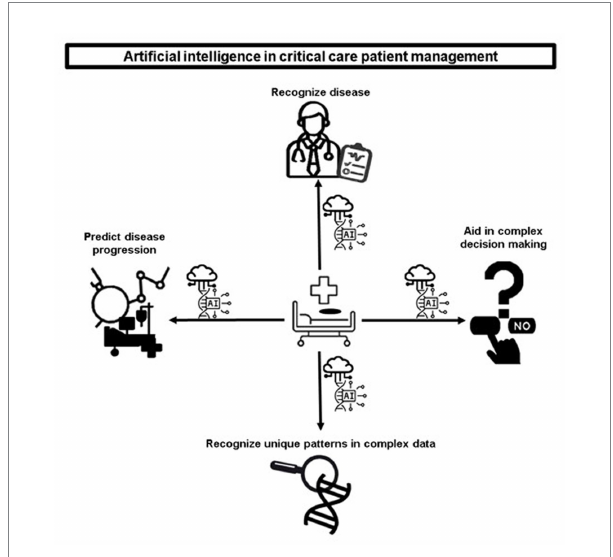
FIGURE 1 Artificial intelligence in critical care